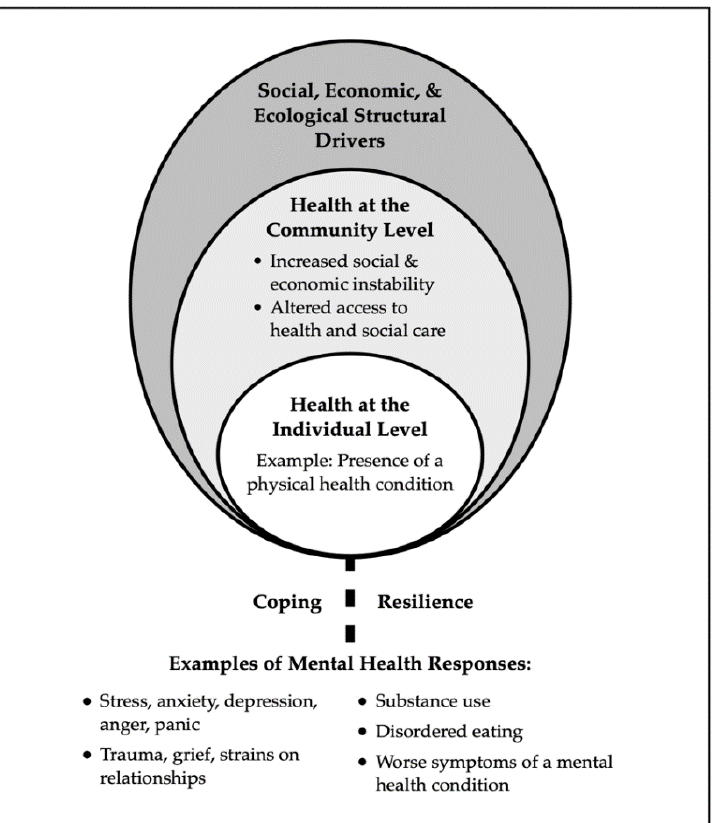
Figure 3. Factors impacting mental health for those with physical health conditions that present risk of severe COVID-19 infection. of severe COVID-19